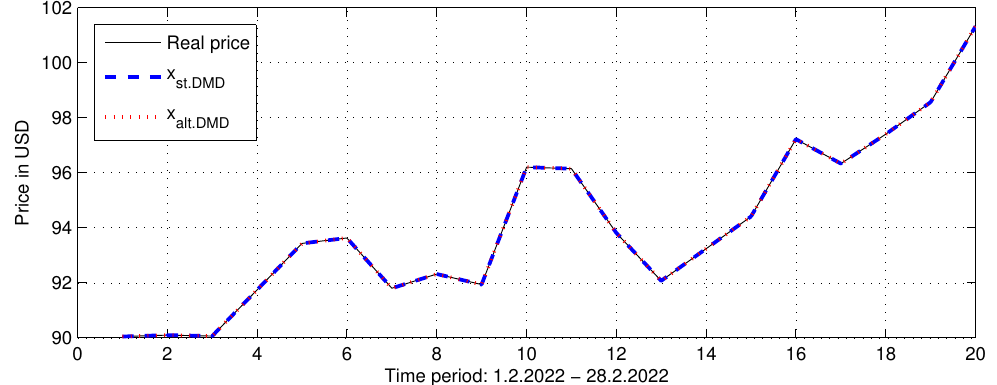
Figure 10. Two approximations of Brent Crude Oil price for the period 1 February 2022–28 February 2022 by Standard DMD and Alternative DMD